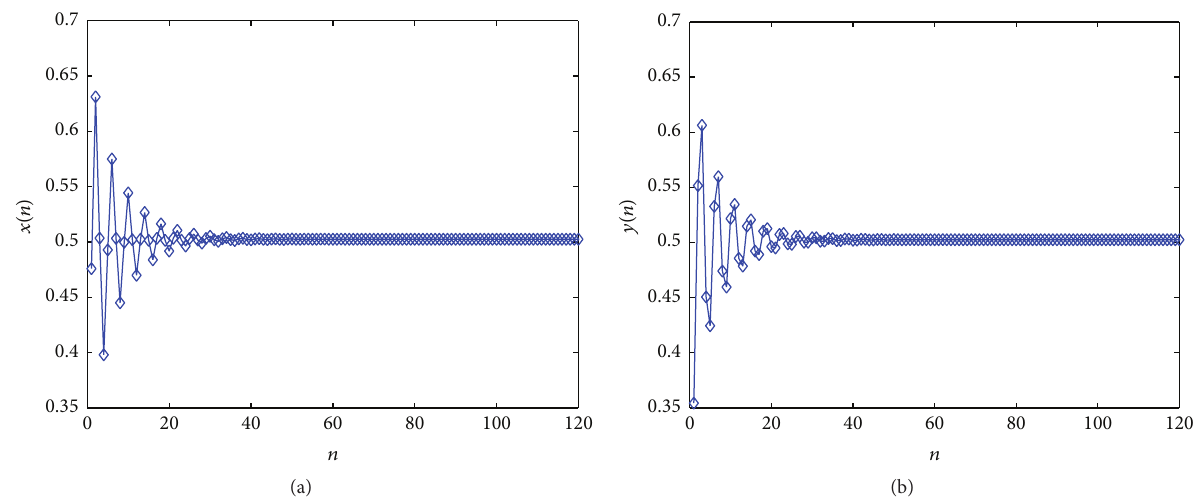
Figure 4: Time history diagram of the controlled delayed species model (17) for 𝑘 3 = −0.41 and 𝑟 = 2.01 . The initial values are [𝑥(0) = 0.2,𝑦(0) = 0.2]